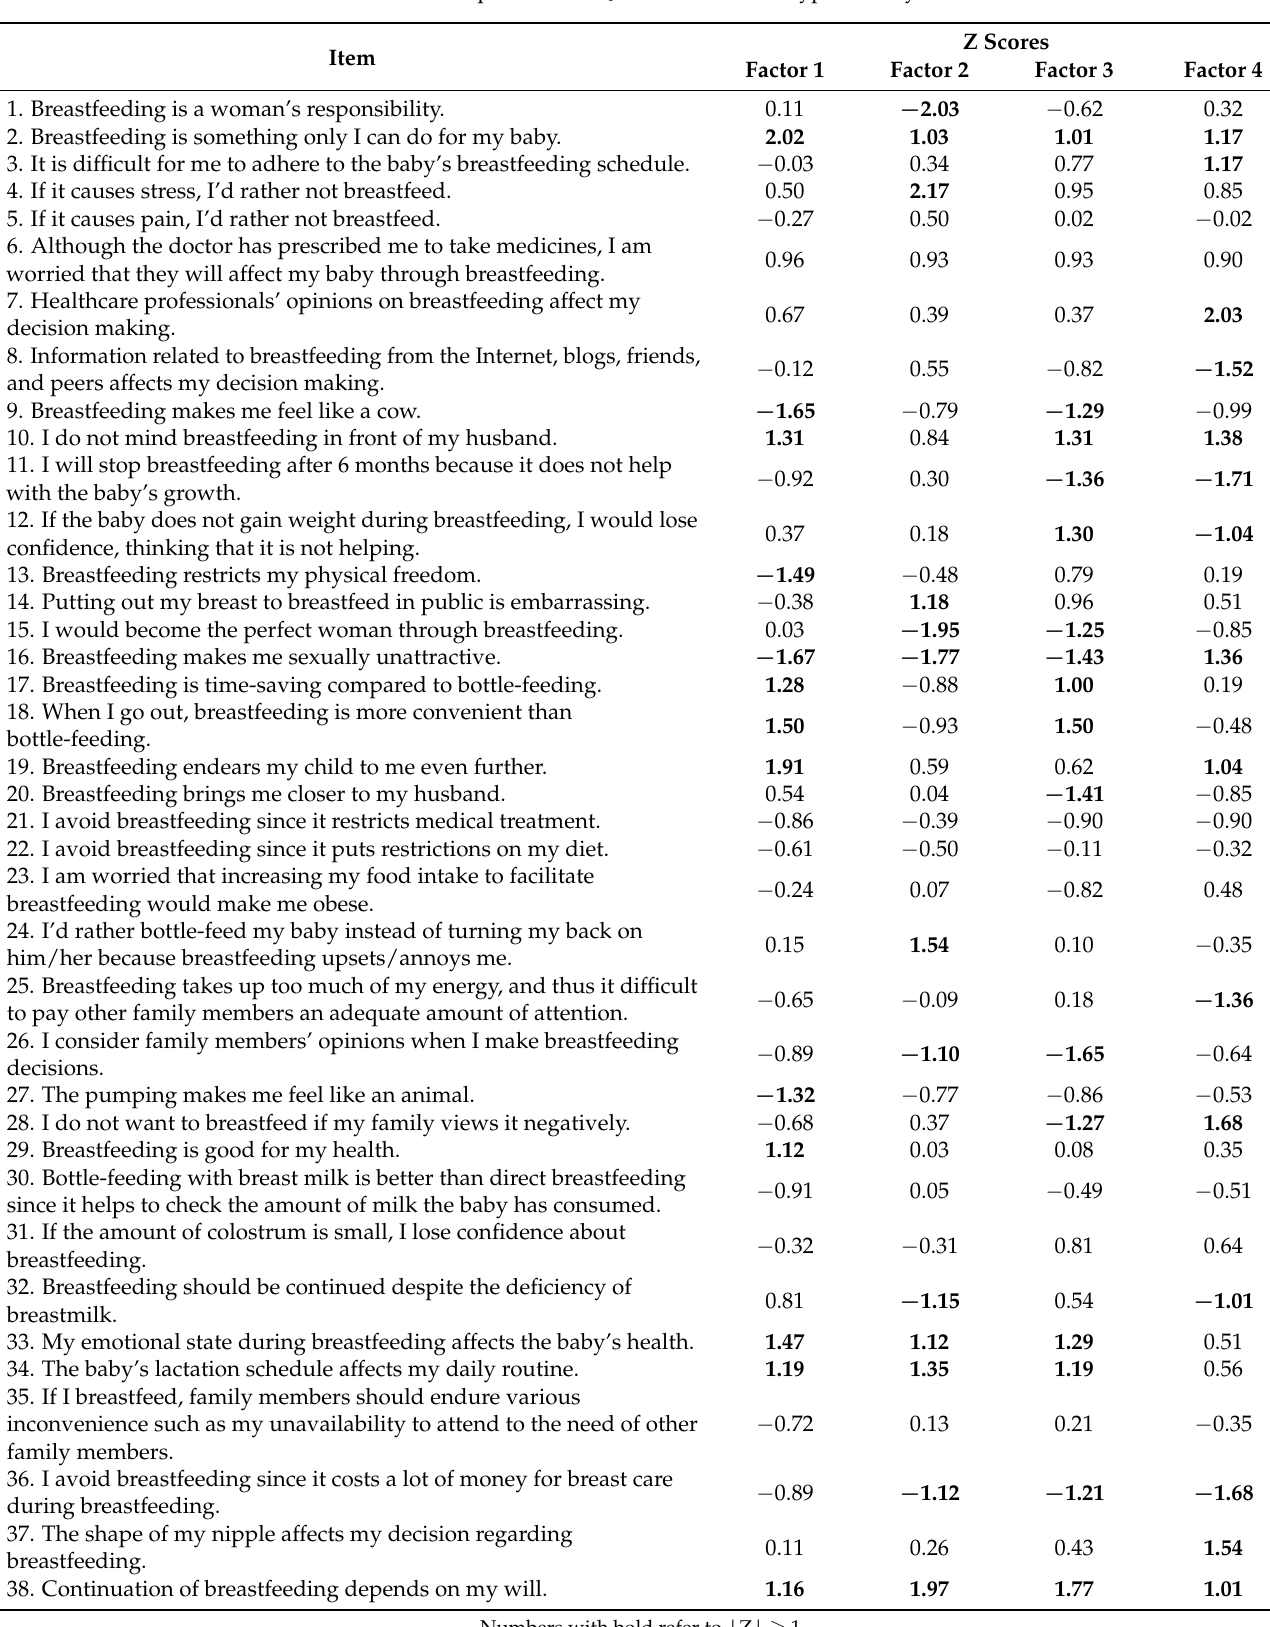
Table 2. Item descriptions with Q-set numbers and typical array Z